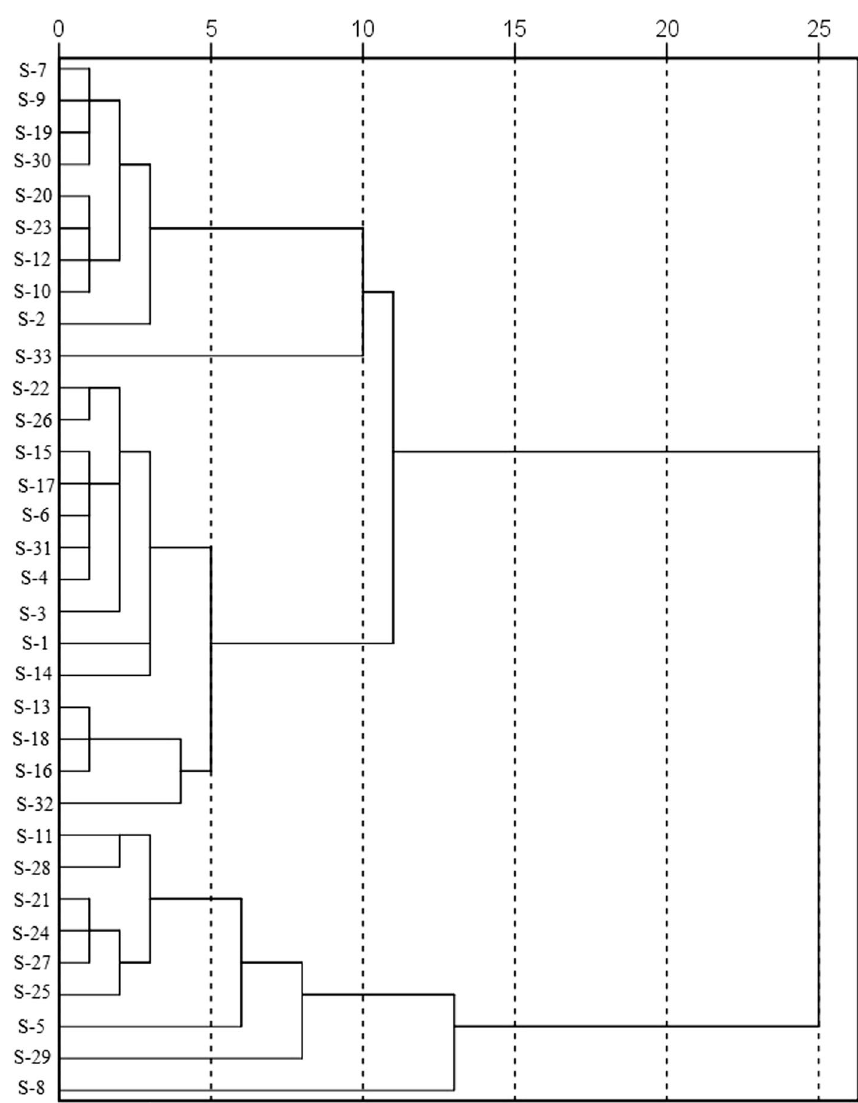
Fig. 6 Dendrogram based on hierarchical cluster analysis, highlighting on spatio-similarity of the samples for the study area